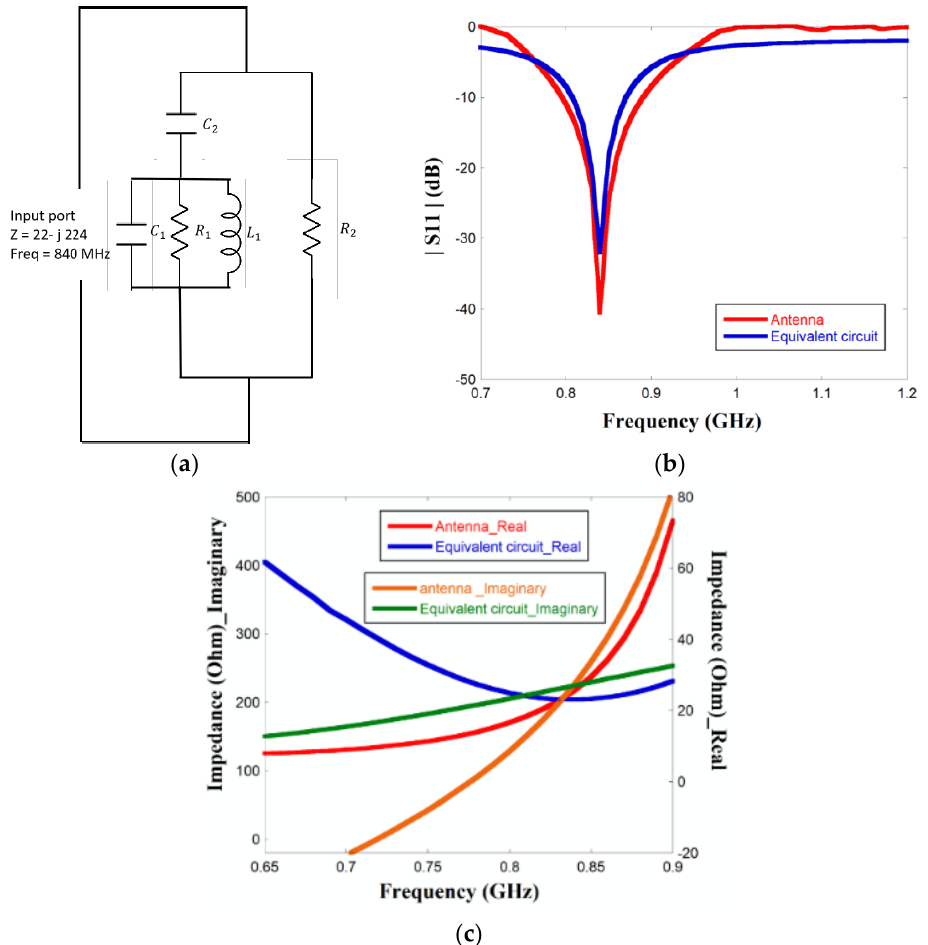
Figure 8. ( a ) Equivalent circuit of the proposed antenna. ( b ) Comparing results of | S 11| between HFSS and ADS. ( c ) Comparing results of Impedance (Real and imaginary) between HFSS and ADS. Advanced Design System (ADS) software is used for the interpretation of the equiv- alent circuit. The value of the lumped components is unveiled from the software. The corresponding circuit is simulated in ADS software at 840 MHz without accounting for the PIN diodes. The main objective of the simulation is to signify the matching property of the recommended antenna without any external matching circuit. The comparable data